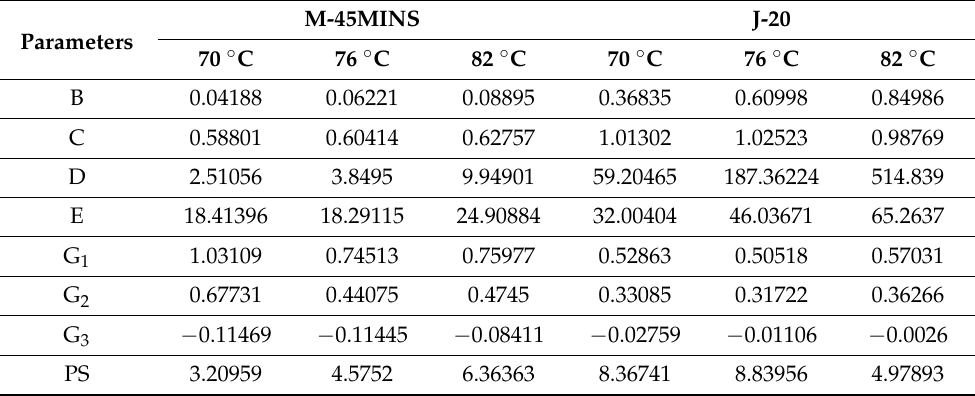
Table 6. Viscoelastic parameters and